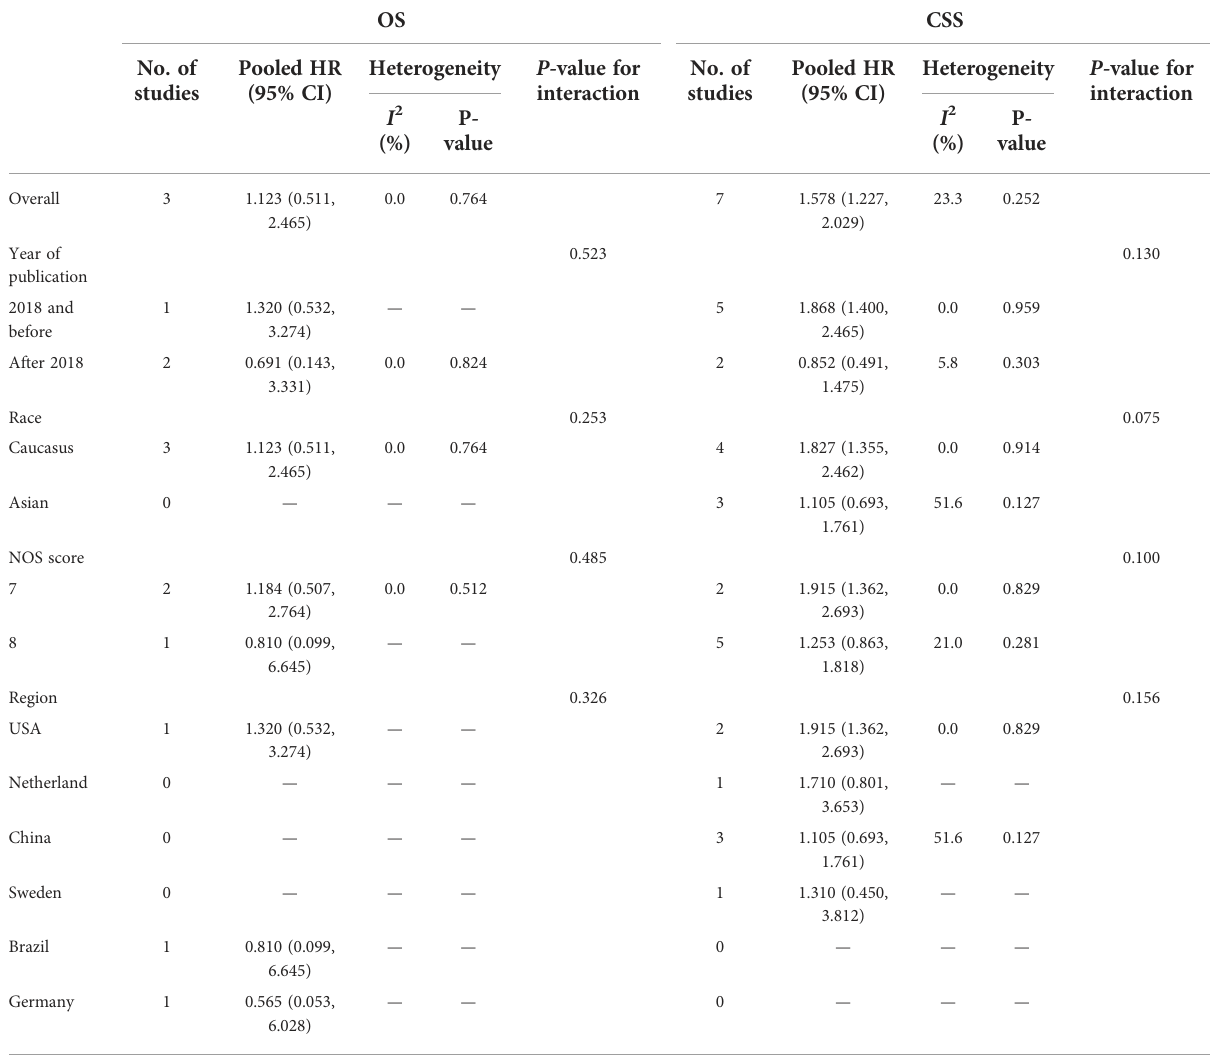
TABLE 2 Subgroup analyses between PD-L1 expression and survival